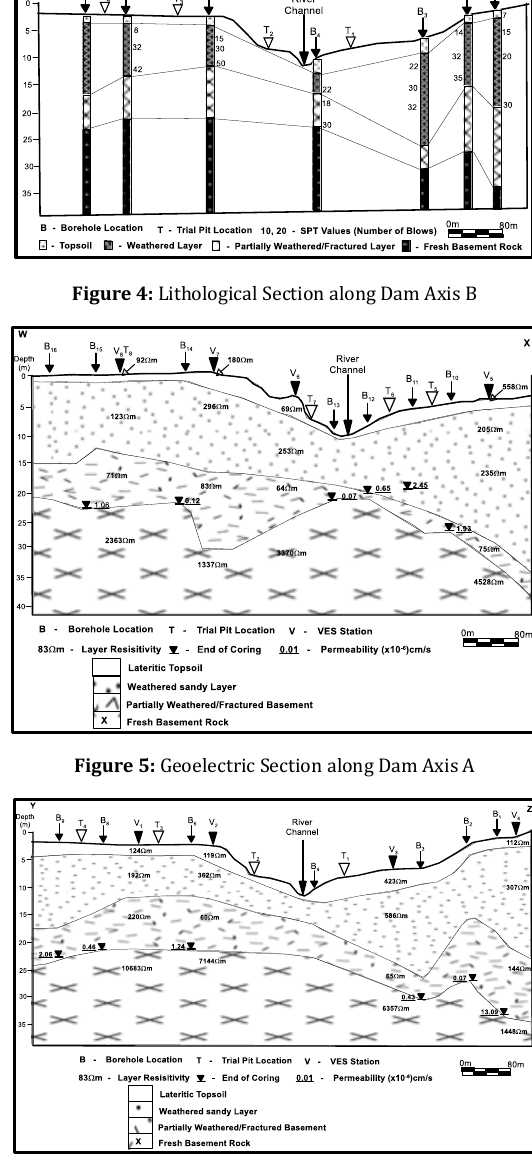
Figure 6: Geoelectric Section along Dam Axis B